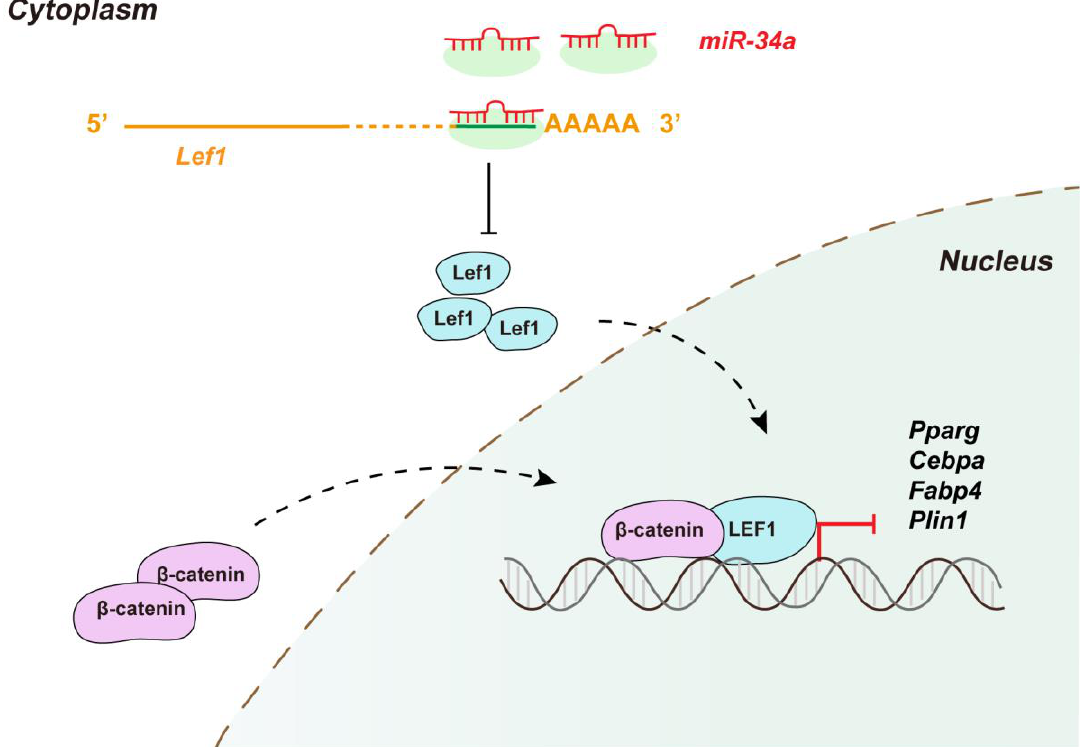
Figure 11. The process of miR-34a / Lef1 regulating adipogenesis. Lef1 transferred to nucleus and combined with β -catenin to suppress the transcription of adipogenic markers, such as Pparg , Cebpa , Fabp4, and Plin1 , while the suppressive function of Lef1 can be inhibited by miR-34a . miR-34a mediated Lef1 to regulate lipid droplet deposition in C2C12 cells. The lipid droplets’ accumulation in myoblasts is an important aspect to enhance the IMF content.